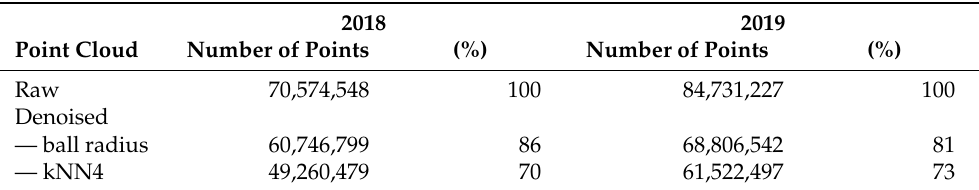
Table 3. Number of points in raw point cloud (post-processing level I) and after denoising (post- processing level II) in CloudCompare. We tested two low-pass filter options: (i) filtering points by a ball radius, which is automatically detected by the software and (ii) filtering by a number of 4 neighbouring points (kNN4).